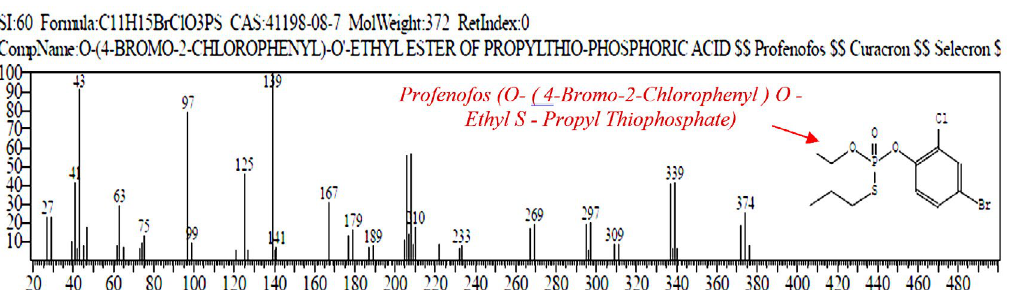
Fig. 8. The chromoatogram and chemical structure of Profenofos[O-(4-Bromo-2-Chlorophenyl) -O’-Ethyl Ester Of Propylthio-Phosphoric Acid] at observation t = 96 hours